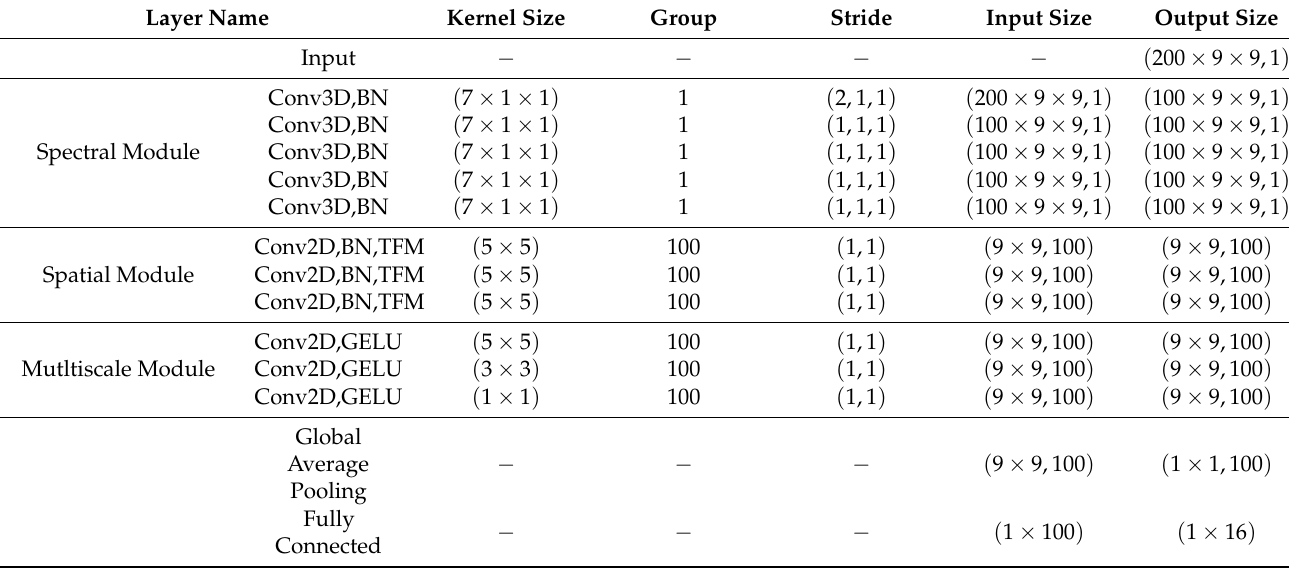
Table 1. Implementation details for an example of the